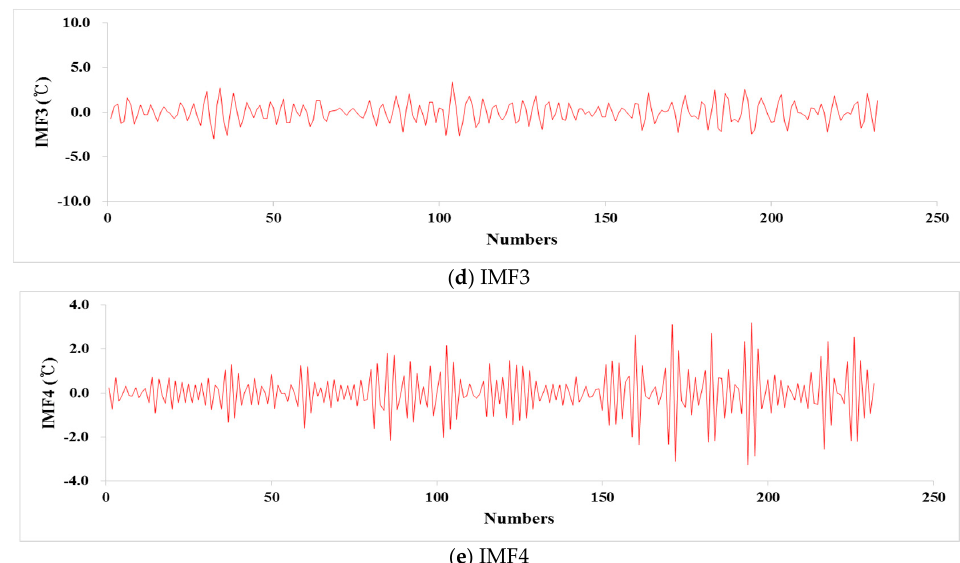
Figure 11. Original water temperature and intrinsic mode functions (IMF1, IMF2, IMF3, and IMF4) decomposed using the VMD algorithm ( K = 4 and α = 10).